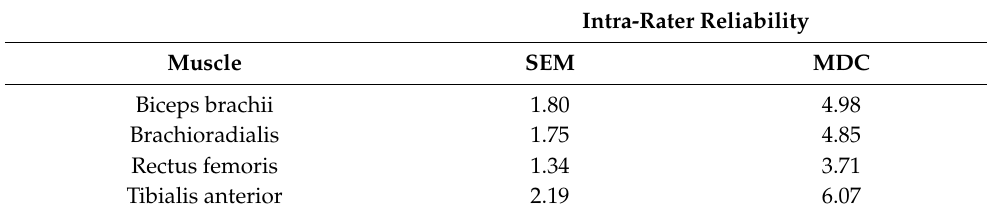
Table 3. Absolute Reliability Indices for the myotonometer’s muscle tone in intra-rater reliability.